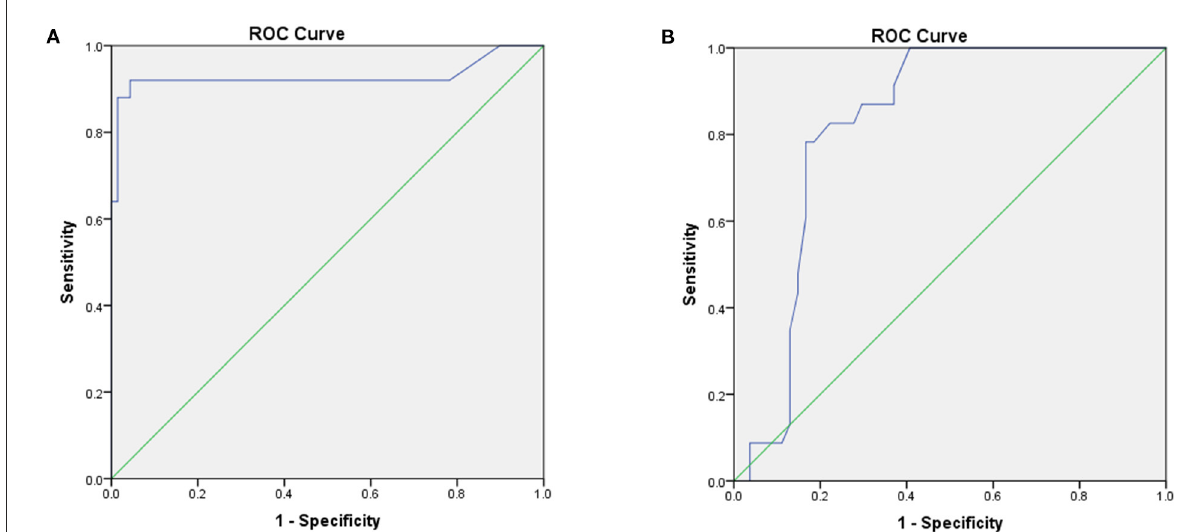
FIGURE3 ROC analyses of the optimal cutoff values of the short-coupled interval triggering torsade de pointes (TdP) (A) and QRS duration of ventricular extrasystole (VE) (B) for predicting the right ventricular outflow tract (RVOT) origin.